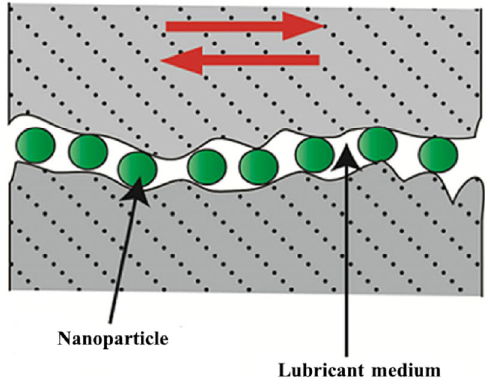
Fig. 8 Ball bearing mechanism by NP-based lubrication